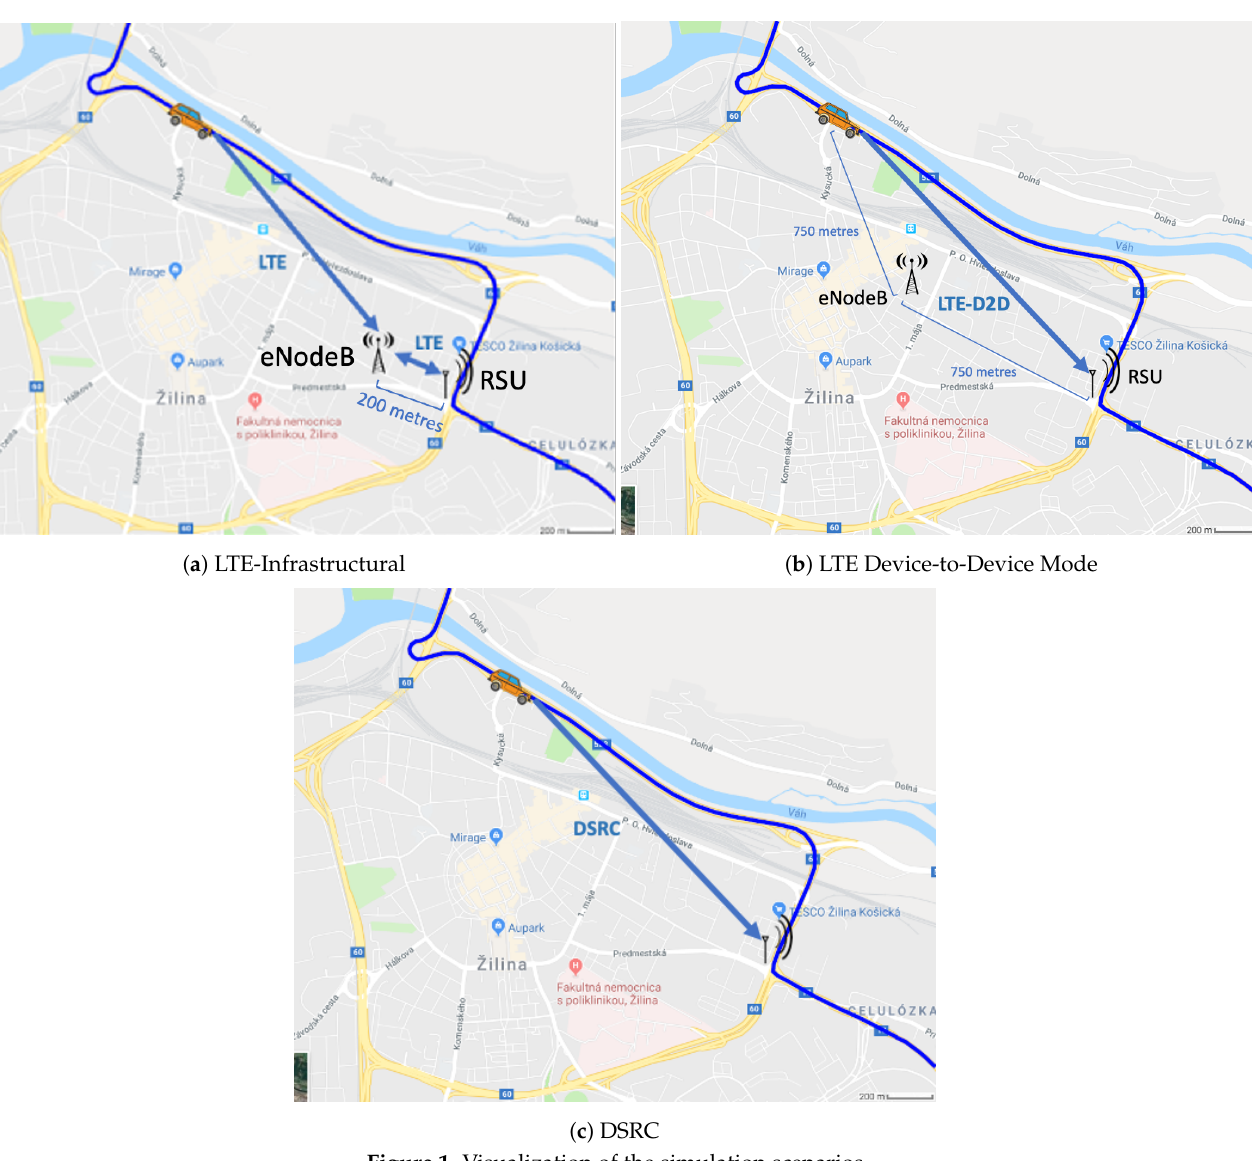
Figure 1. Visualization of the simulation